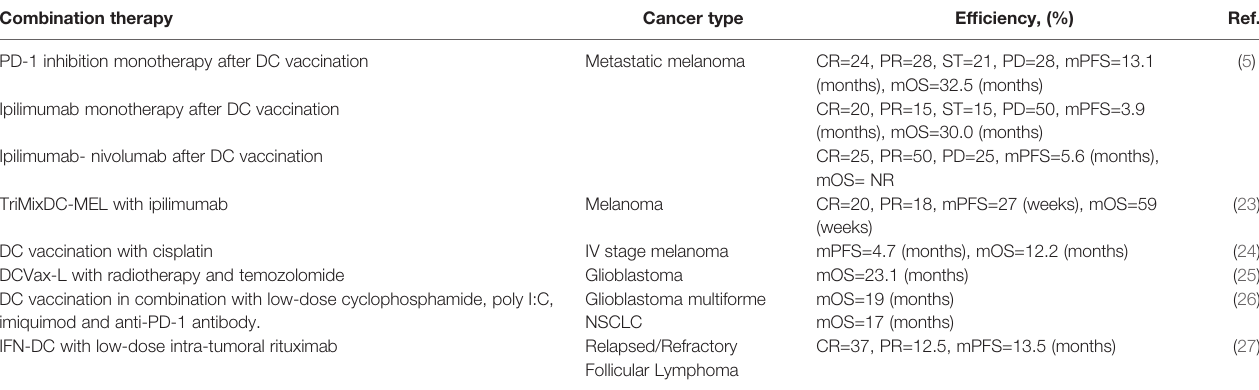
TABLE 1 | Effectiveness of personalized therapeutic DC vaccine in combination with other antitumor therapy